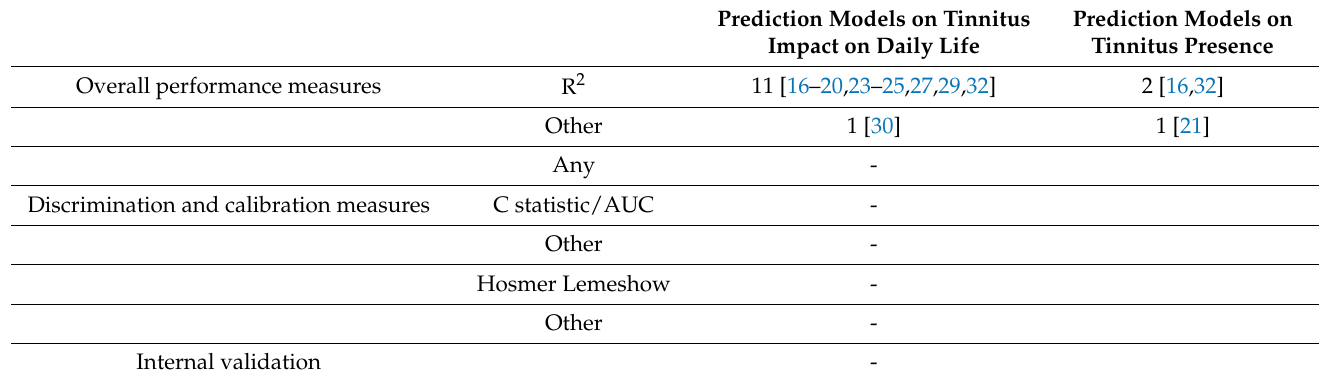
Table 5. Overall reported performance measures.